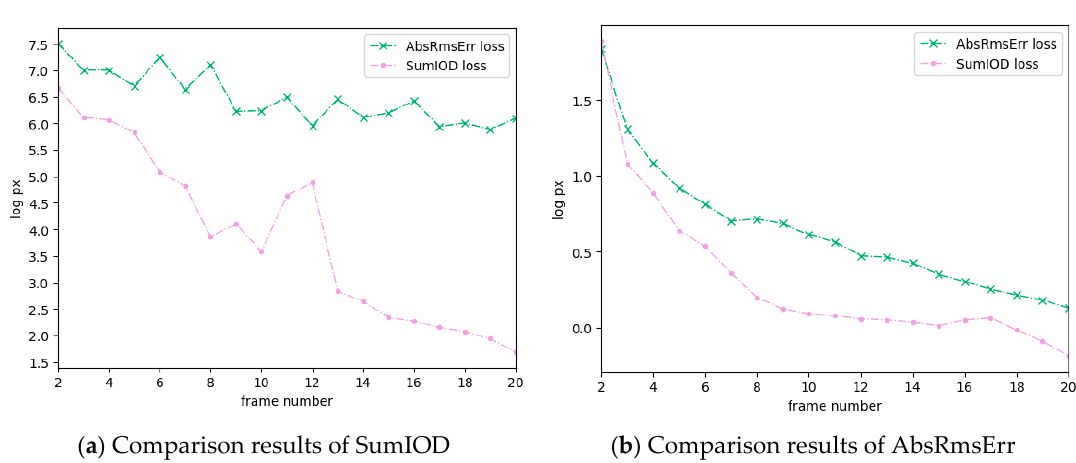
Figure 8. AbsRmsErr loss vs. sum of the index of dispersion (SumIOD) loss. The green dotted line is obtained by the pose search algorithm with AbsRmsErr as the loss function. The magenta dotted line is obtained by the pose search algorithm with SumIOD as the loss function. Both methods use a random pose as the initial solution.